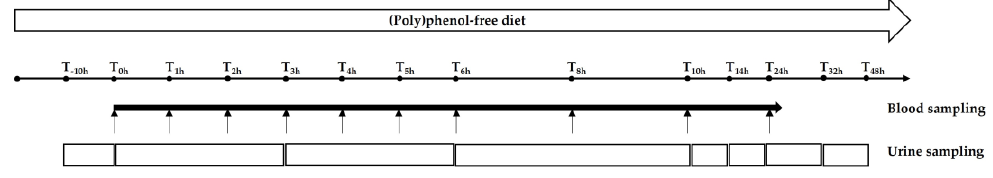
Figure 2. Blood and urine collection time during the 48 h period of both phase I and phase II.